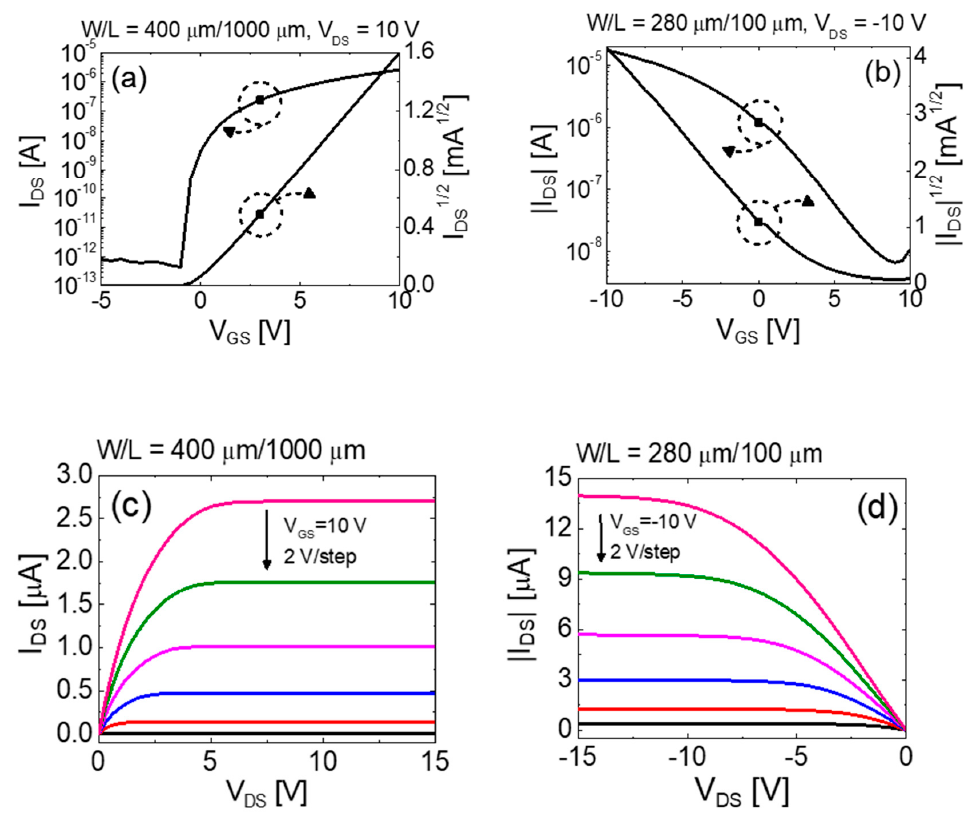
Figure 4. ( a , b ) transfer and ( c , d ) output curves of the fabricated vertically stacked top-gate IGZO and Figure 4. ( a,b ) transfer and ( c,d ) output curves of the fabricated vertically stacked top-gate IGZO and bottom-gate SnO TFTs, bottom-gate SnO TFTs, respectively.